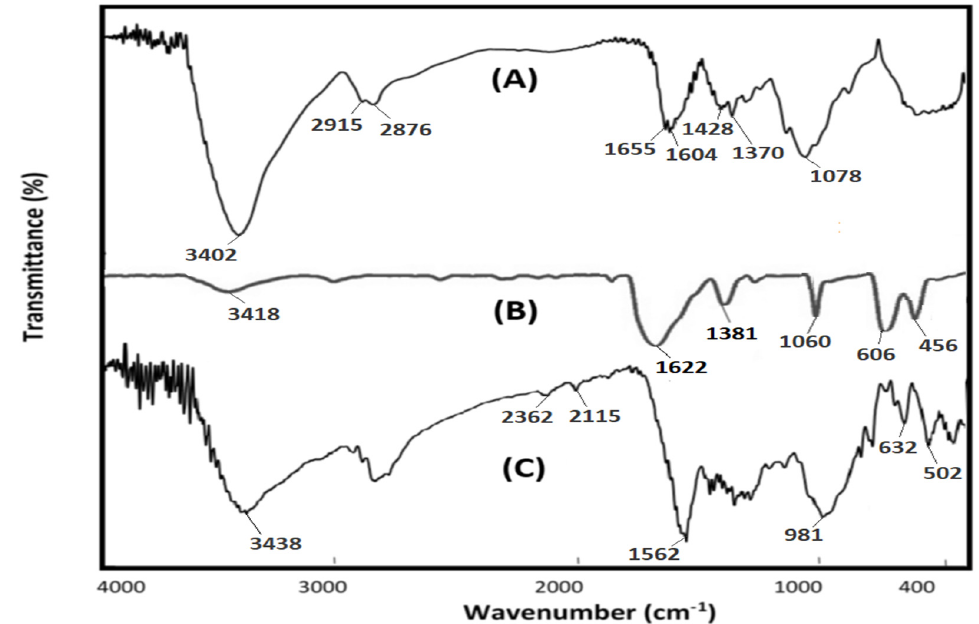
Figure 1. FTIR of ( A ) chitosan, ( B ) CuO nanoparticles, ( C ) Chitosan-CuO nanocomposites (15